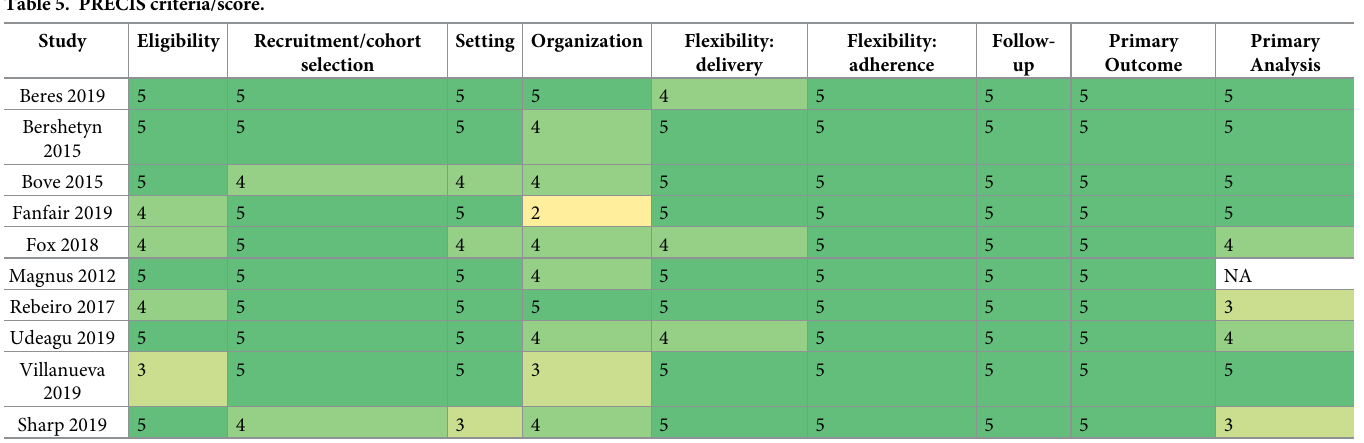
� Darker colors represent pragmatic approaches; lighter colors represent explanatory approaches. NA, not